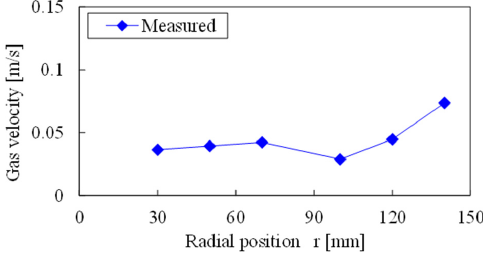
Figure 5. Radial gas velocity distribution obtained by experimental measurements.